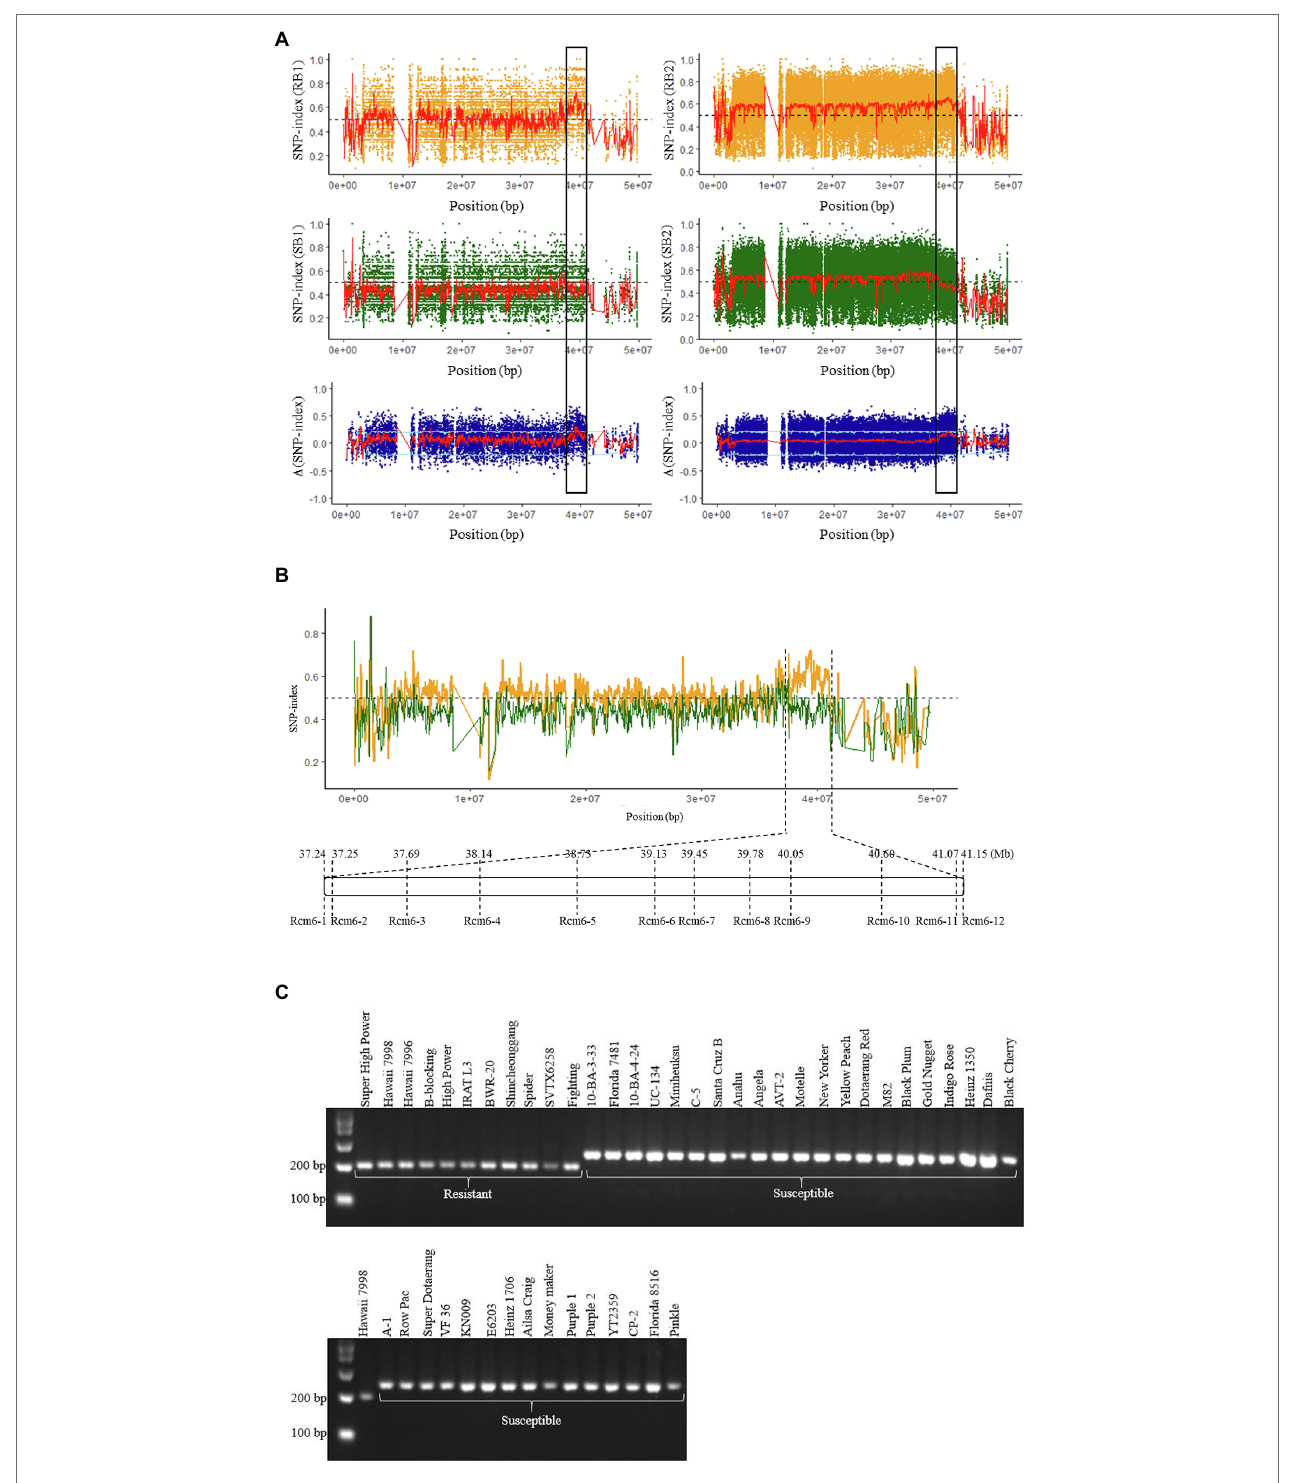
FIGURE 2 | Candidate genomic region for bacterial canker resistance and schematic location of InDel markers in the Rcm6 . (A) SNP-index plots for chromosome 6 of resistant (orange), susceptible (dark green) bulks, and Δ (SNP-index; dark blue) with the “E6203” as a reference in experiment-I (left) and II (right). Red lines indicate the sliding window average of 100 kb interval with 10 kb increments for SNP-index. Δ (SNP-index) was obtained by subtracting the susceptible bulk SNP-index from the resistant bulk SNP-index. Light blue line indicates the statistical CI at significance level ( p < 0.05). Black boxes indicate candidate genomic region for bacterial canker resistance. (B) Schematic location of InDel markers in Rcm6 . Average SNP-index plots for chromosome 6 of the resistant (orange) and susceptible (dark green) bulks with “E6203” as a reference in experiment-I. (C) Genotyping of Rcm6-9 in 47 tomato cultivars. Eleven resistant and 36 susceptible cultivars were discriminated by Rcm6-9